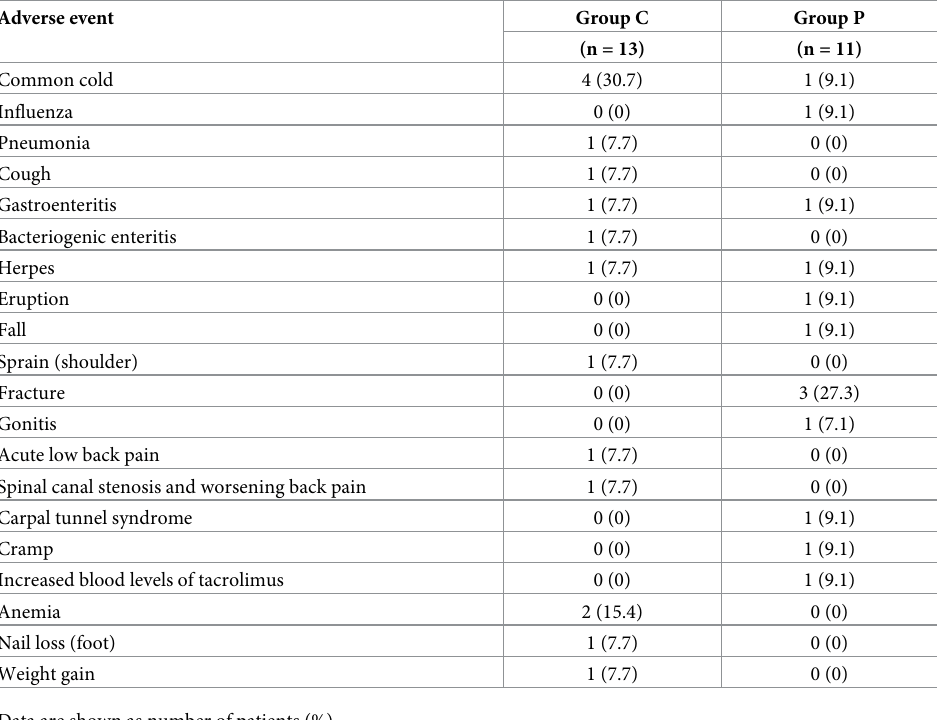
Table 2. Adverse events over the course of the study in the SAS. Adverse event Group C Group P (n = 13) (n = 11) Common cold 4 (30.7) 1 (9.1) Influenza 0 (0) 1 (9.1) Pneumonia 1 (7.7) 0 (0) Cough 1 (7.7) 0 (0) Gastroenteritis 1 (7.7) 1 (9.1) Bacteriogenic enteritis 1 (7.7) 0 (0) Herpes 1 (7.7) 1 (9.1) Eruption 0 (0) 1 (9.1) Fall 0 (0) 1 (9.1) Sprain (shoulder) 1 (7.7) 0 (0) Fracture 0 (0) 3 (27.3) Gonitis 0 (0) 1 (7.1) Acute low back pain 1 (7.7) 0 (0) Spinal canal stenosis and worsening back pain 1 (7.7) 0 (0) Carpal tunnel syndrome 0 (0) 1 (9.1) Cramp 0 (0) 1 (9.1) Increased blood levels of tacrolimus 0 (0) 1 (9.1) Anemia 2 (15.4) 0 (0) Nail loss (foot) 1 (7.7) 0 (0) Weight gain 1 (7.7) 0